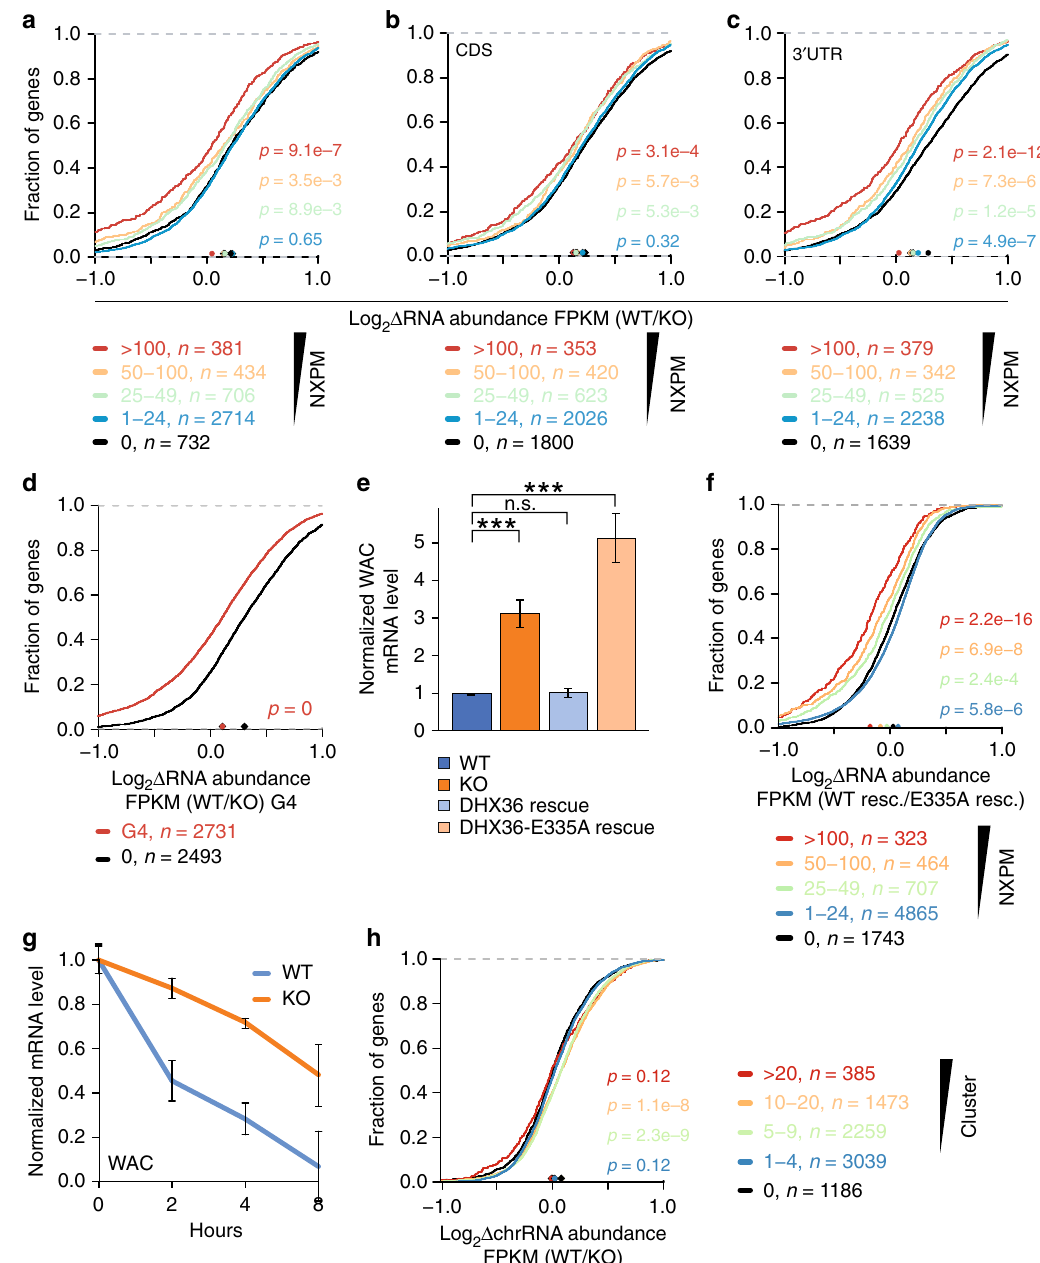
Fig. 4 DHX36-KO results in increased target RNA abundance. a DHX36-KO results in an increased target mRNA abundance shown by CDF comparing changes in target mRNA abundance of DHX36-KO ( n = 3) and parental HEK293 cells ( n = 3). Target mRNAs were binned in accordance to the number of NXPM obtained by DHX36-E335A PAR-CLIP. Signi fi cance was determined using a two-sided Kolmogorov – Smirnov (KS) test. b Same as in a , except mRNAs were binned based on the number of NXPM in the CDS. c Same as in a , except mRNAs were binned based on the number of NXPM in the 3 ′ UTR. d Same as in a , except mRNAs were binned based on whether they harbor a G4-site identi fi ed previously 10 overlapping with PAR-CLIP binding sites. e Quanti fi cation of WAC mRNA levels in HEK293 wild-type cells (WT), DHX36-KO cells (KO), DHX36-KO cells with FH-DHX36 overexpression (DHX36 rescue), and DHX36-KO cells with FH-DHX36-E335A overexpression (DHX36-E335A rescue) by RT-qPCR. WAC mRNA levels were normalized to the level of U6 snRNA. Median WAC WT levels were scaled to 1. Signi fi cance was calculated using a Student ’ s t -test ( n = 3). Signi fi cance levels: * P < 0.05, ** P < 0.01, and *** P < 0.001 compared to normalized WT WAC level. Error bars represent standard deviations of three experiments. f Same as in a , except target mRNA abundance in HEK293 DHX36-KO cells with FH-DHX36 overexpression were plotted over target mRNA abundance in HEK293 DHX36-KO cells with FH-DHX36-E335A overexpression. g DHX36 target mRNA WAC show increased half-life upon DHX36-KO shown by qPCR after transcriptional block with actinomycin D and isolation of RNA at the indicated timepoints. Error bars represent standard deviations of three experiments. h DHX36 regulates target mRNA abundance at a posttranscriptional rather than transcriptional level shown by CDFs comparing changes in nascent target mRNA abundance puri fi ed from chromatin of DHX36 knockout cells ( n = 3) and parental HEK293 cells ( n = 3). Target mRNAs were binned in accordance to